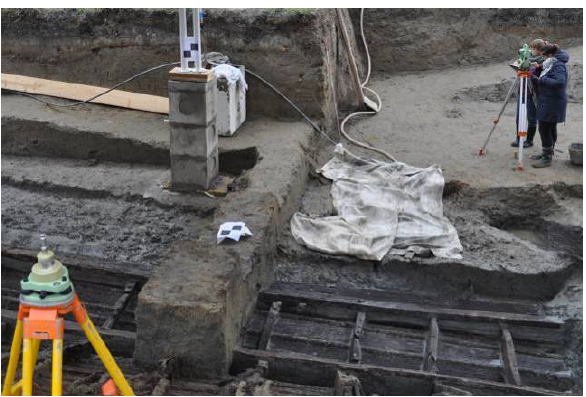
Figure 8. Topographic survey of the control points with total